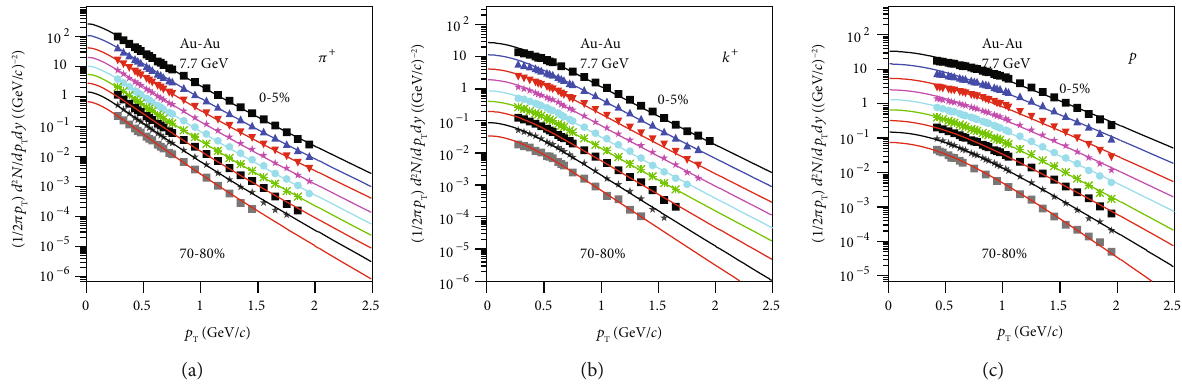
ffiffiffiffiffiffiffiffiffi p = 7 : 7 GeV . s NN